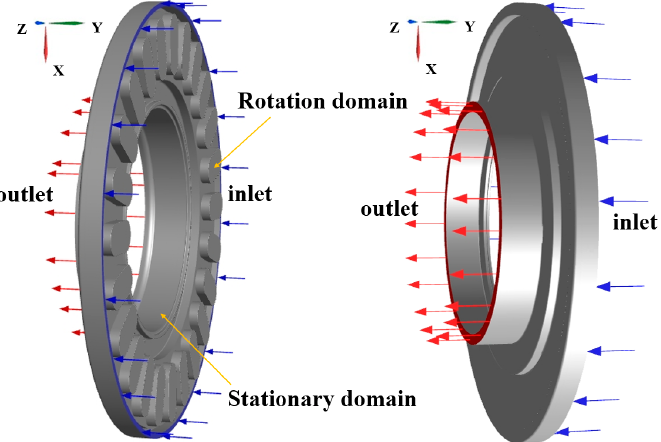
Figure 4. Pressure distribution of the first-stage liquid-sealing impeller.